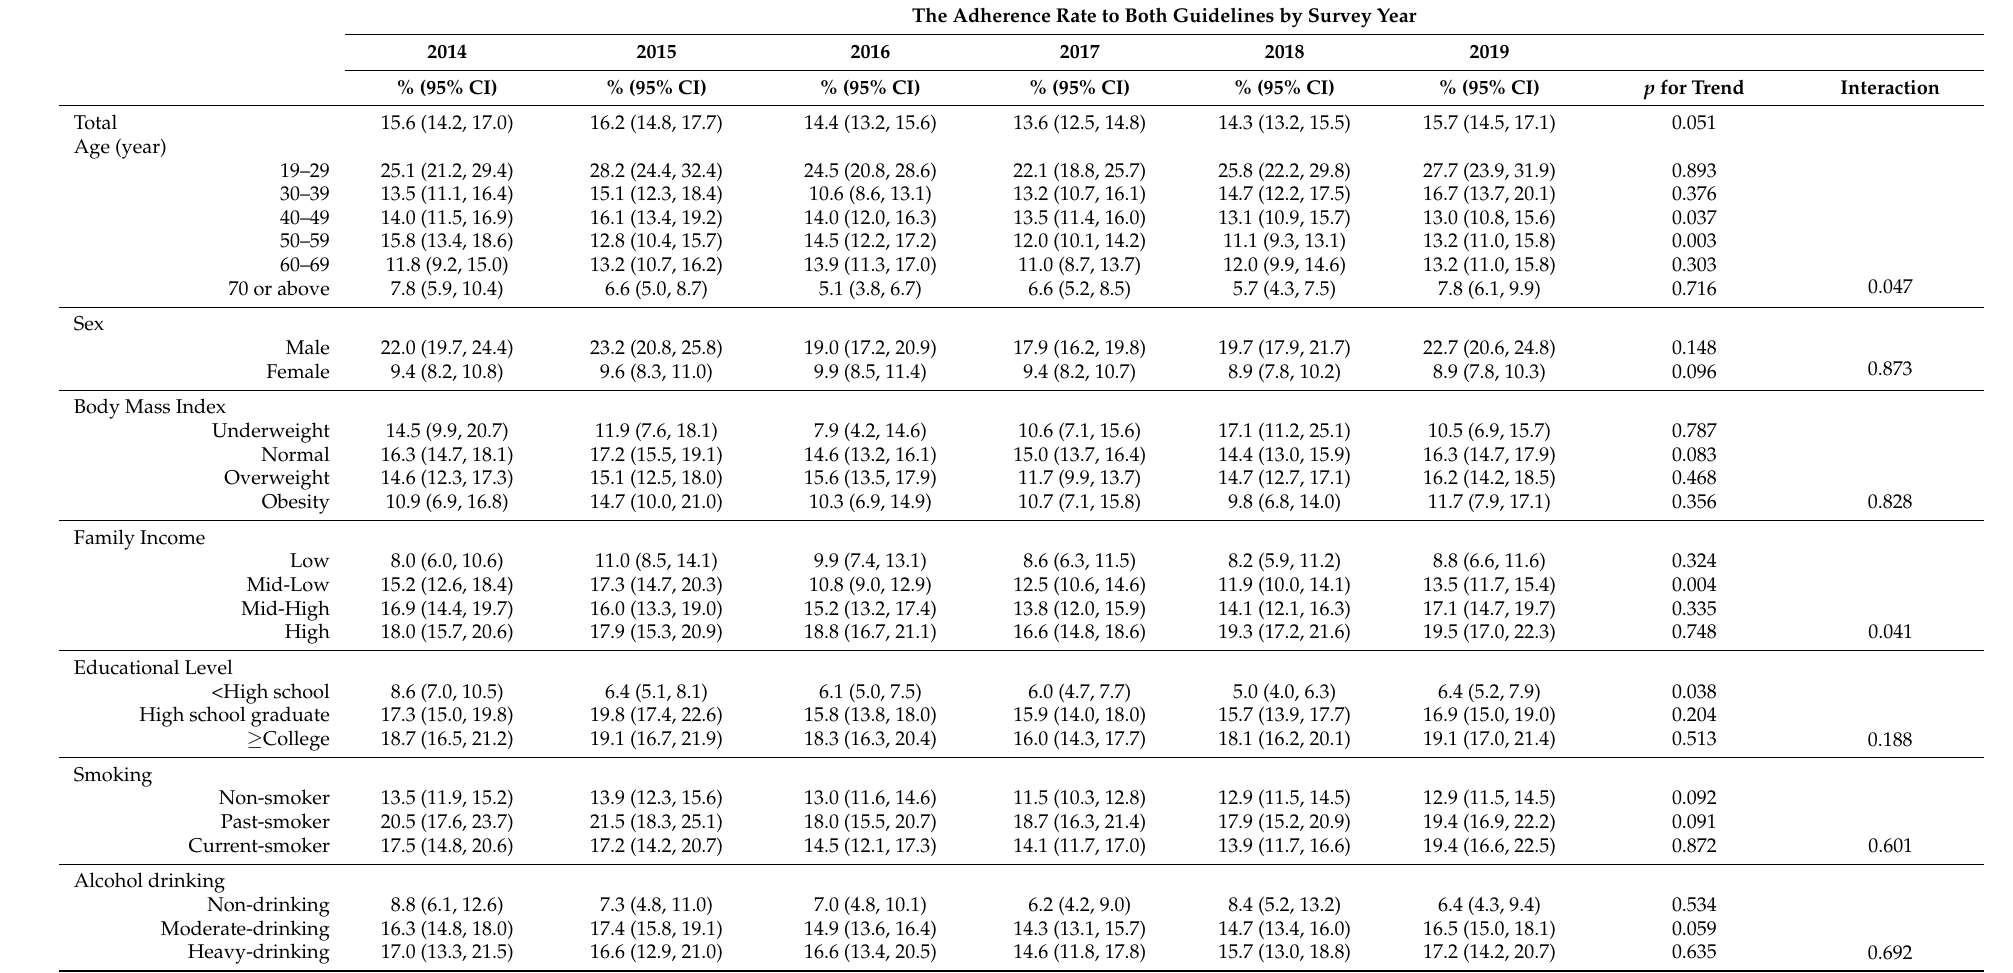
Table 4. Changes in adherence rate to both aerobic and muscle-strengthening PA guidelines by survey